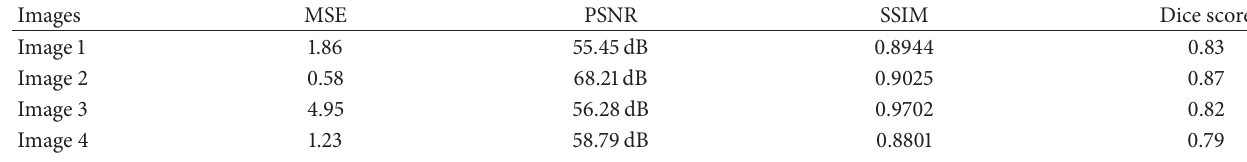
Table 5: Performance analysis parameters for segmented tissues.